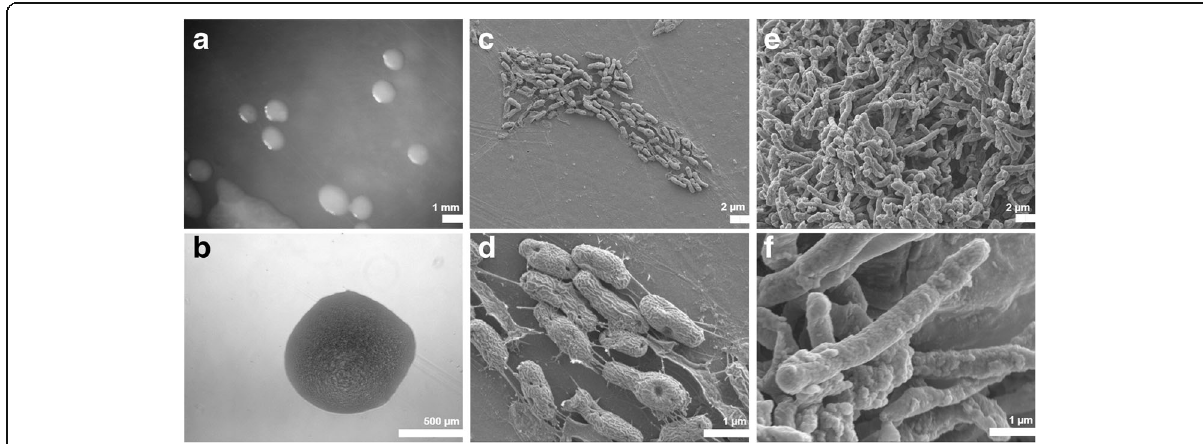
Fig. 1 Colony morphology of E. meliloti strain FSM-MA on solid medium ( a , b ) at 5× ( A ) and 50× ( b ) magnifications as well as scanning electron microscopic images at 4000× ( c,e ) and 20,000× magnifications ( d,f ) of free-living cells ( c,d ) and bacteroids isolated from M. truncatula Jemalong A17 nodules ( e , f